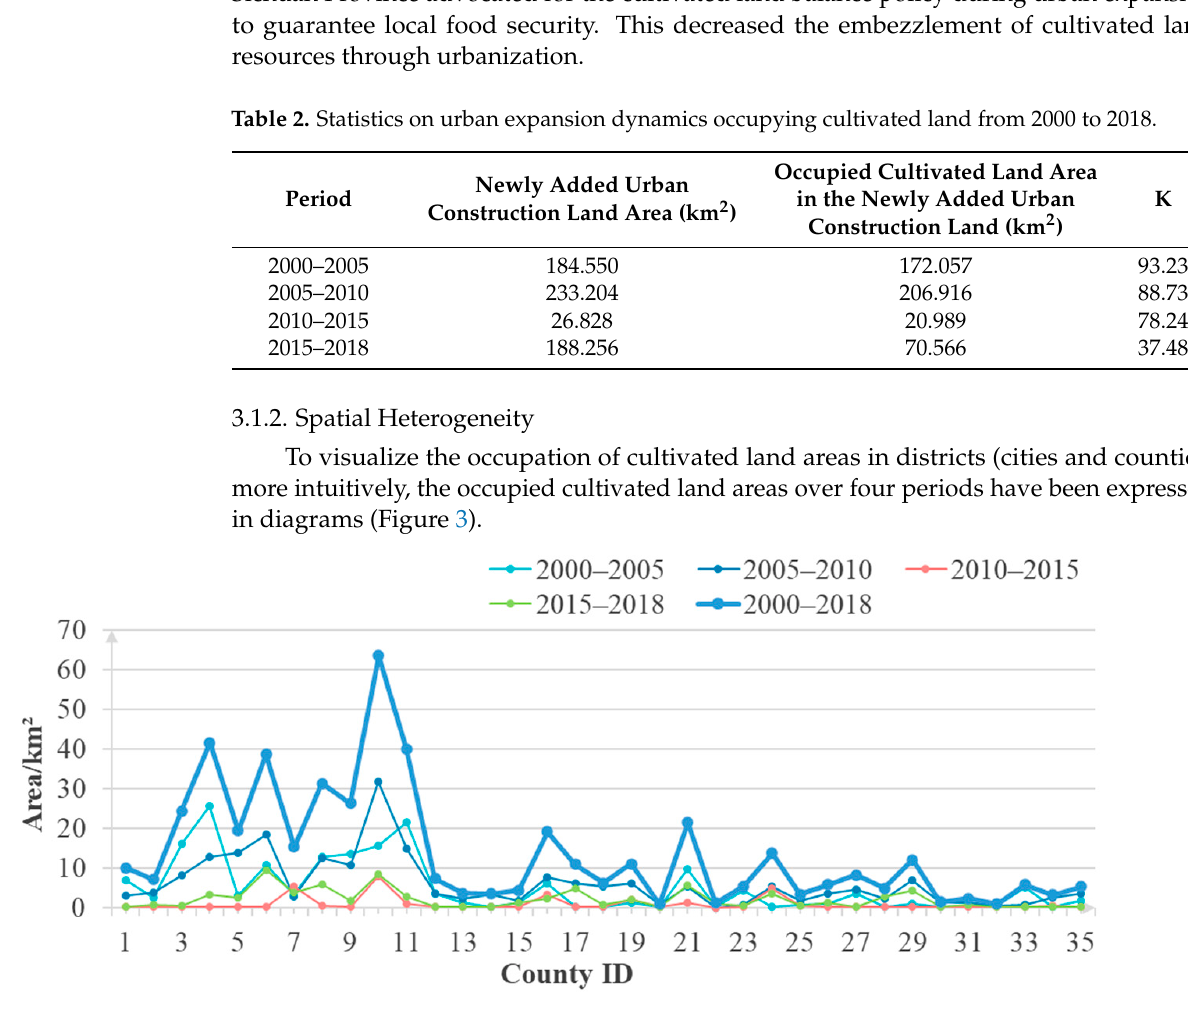
Table 2. Statistics on urban expansion dynamics occupying cultivated land from 2000 to 2018.